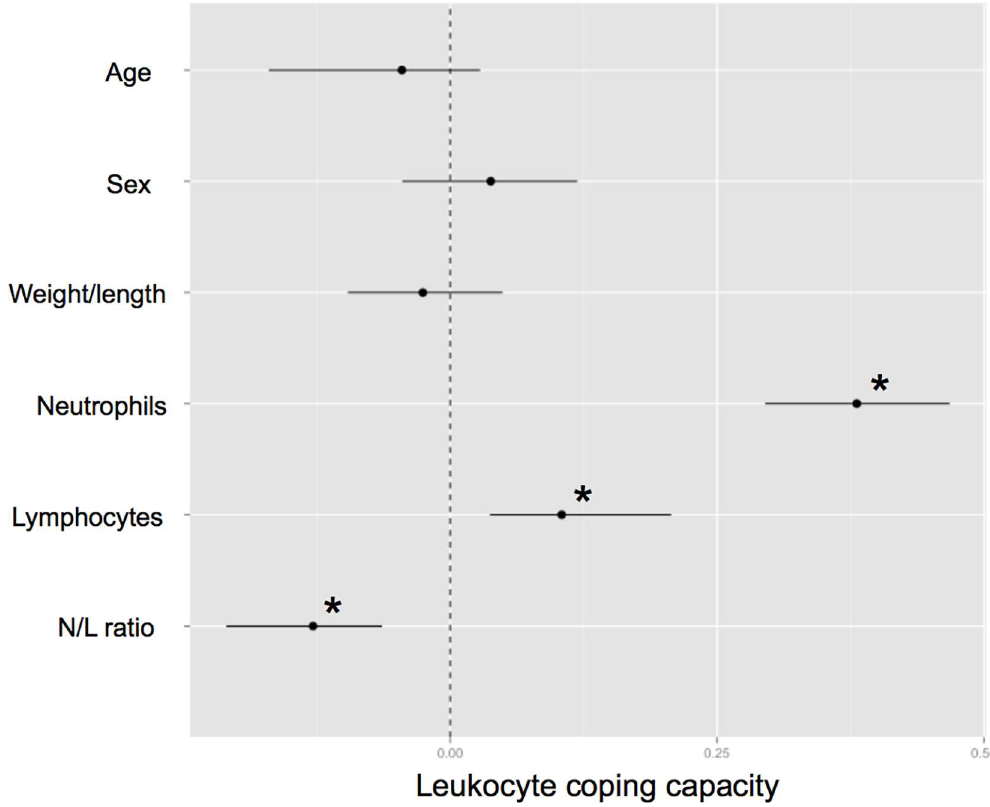
Fig 3. Model averagedparameterestimates and their 95% confidence intervals for the 6 predictors (age class, sex, weight/length ratio, neutrophil counts, lymphocyte counts and neutrophil/lymphocyte ratio) associated with the leukocyte coping capacity. * indicates a parameter with a significant